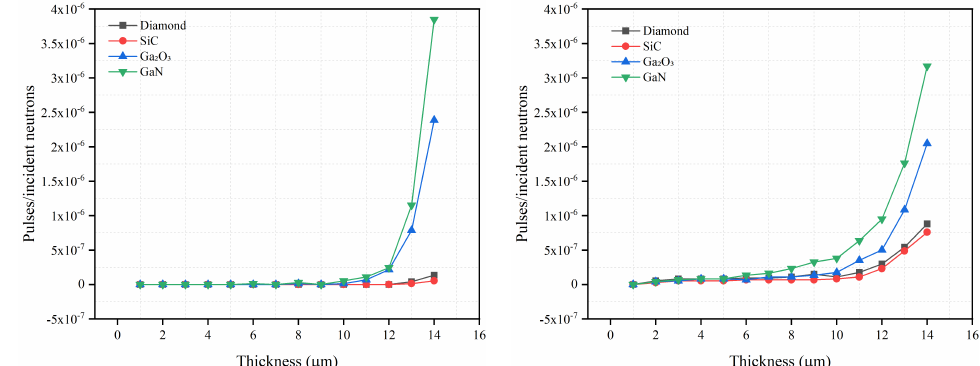
Figure 6. Gamma–ray detection efficiency to 511 keV photons ( left ), to 1460 keV photons ( right ) versus semiconductor thickness for 300 keV LLD with optimal LiF converter layer thickness for diamond, SiC, Ga 2 O 3 and GaN semiconductor materials. The optimal B 4 C converter layer thickness is 30.6 µ m for 300 keV LLD, as shown in Table